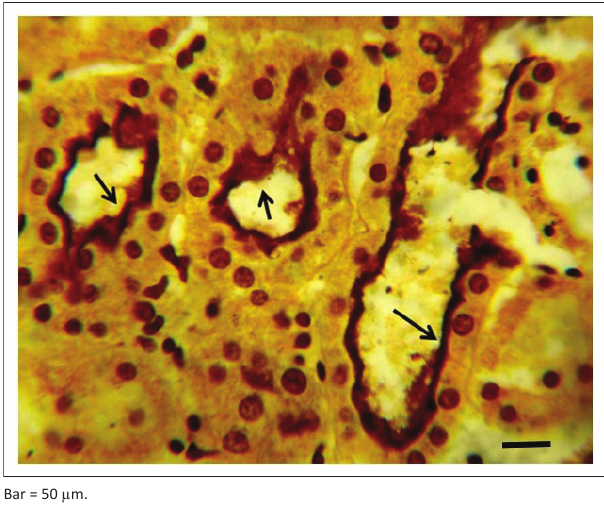
FIGURE 3: Photomicrograph of severely colonised proximal convoluted tubules and absence of interstitial mononuclear cells infiltration in the